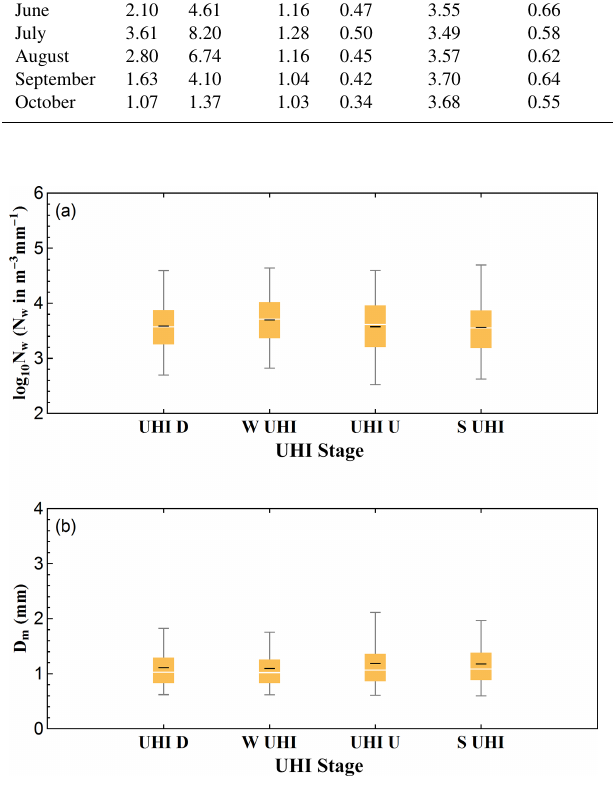
Figure 10. Same as Fig. 8 but for different diurnal periods based on UHI